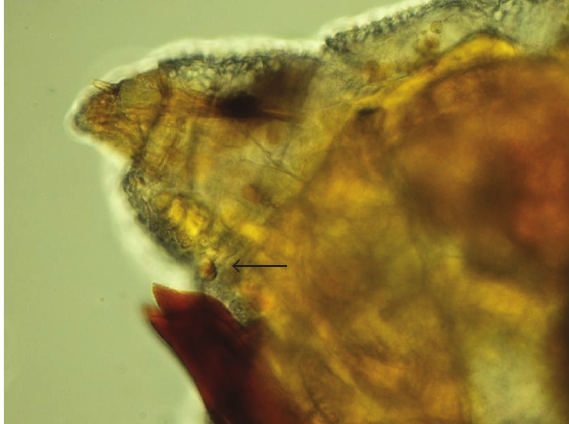
Figure 23: Lateral view of the prothoracic spatula. The head segmentwithantennaistothefarleft.Theheadisseatedinthecollar segment within which the dark red Bolwig’s organ can be seen (far right). On the prothorax between the spatula and the collar segment are the sternal papillae, one of which can be seen as a round, tan colored structure (arrow). When the collar segment inverts it brings the mouth into close juxtaposition to the spatula and the sternal papillae.